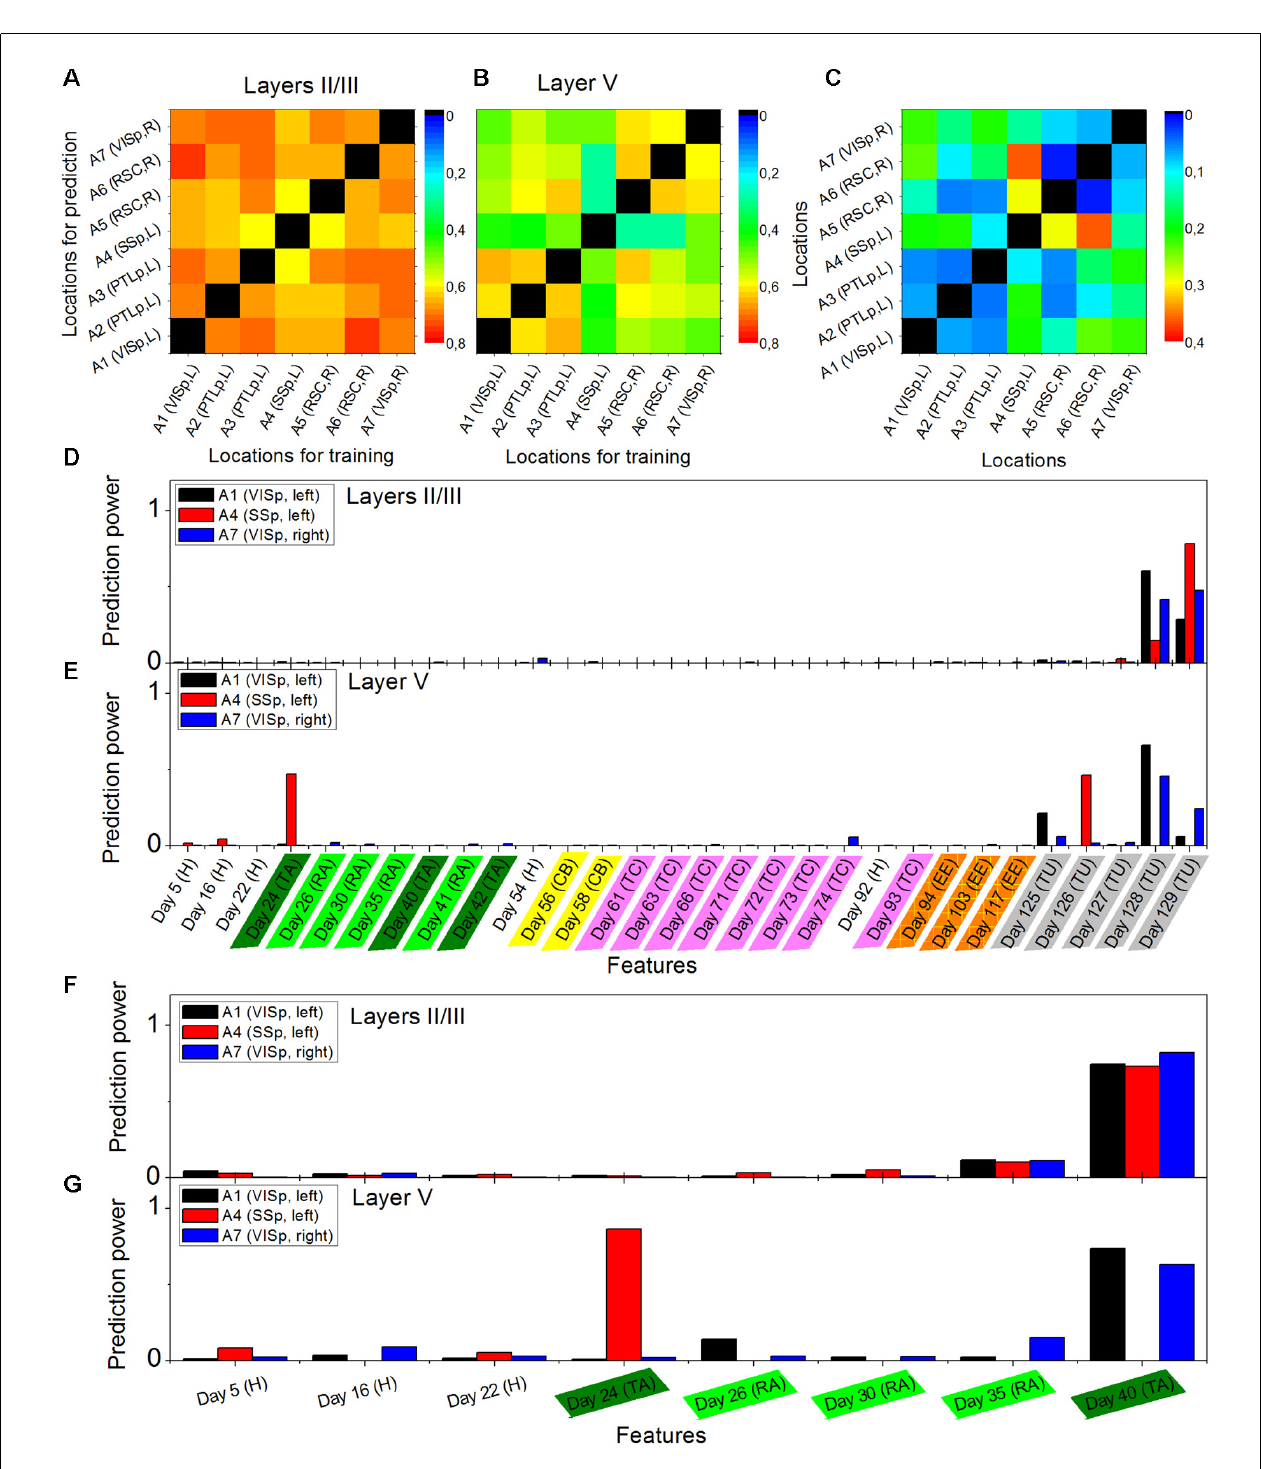
FIGURE 2 | Cross-location prediction performance ˜ M κΛ in layers II/III (A) and in layer V (B) , and their relative difference M s (C) , by using the data from animal Ma. Diagonal elements do not have values. Prediction power distributions of layer II/III model (D) and layer V model (E) trained in cortical location A1 (left VISp), A4 (left primary somatosensory, SSp, and A7 (right VISp), when the neural activities on Day 130 (Tunnel) was used as the target and all previous days in the data set as the features. Panels (F,G) show the prediction power distributions of layer II/III model and layer V model, respectively, when the neural activities on Day 41 (Retrieval A) was used as the target and eight previous days in the data set as the features. Abbreviations: H, home cage; TA, training A; RA, retrieval A; CB, context B; TC, training C; EE, enriched environment and TU, tunnel.